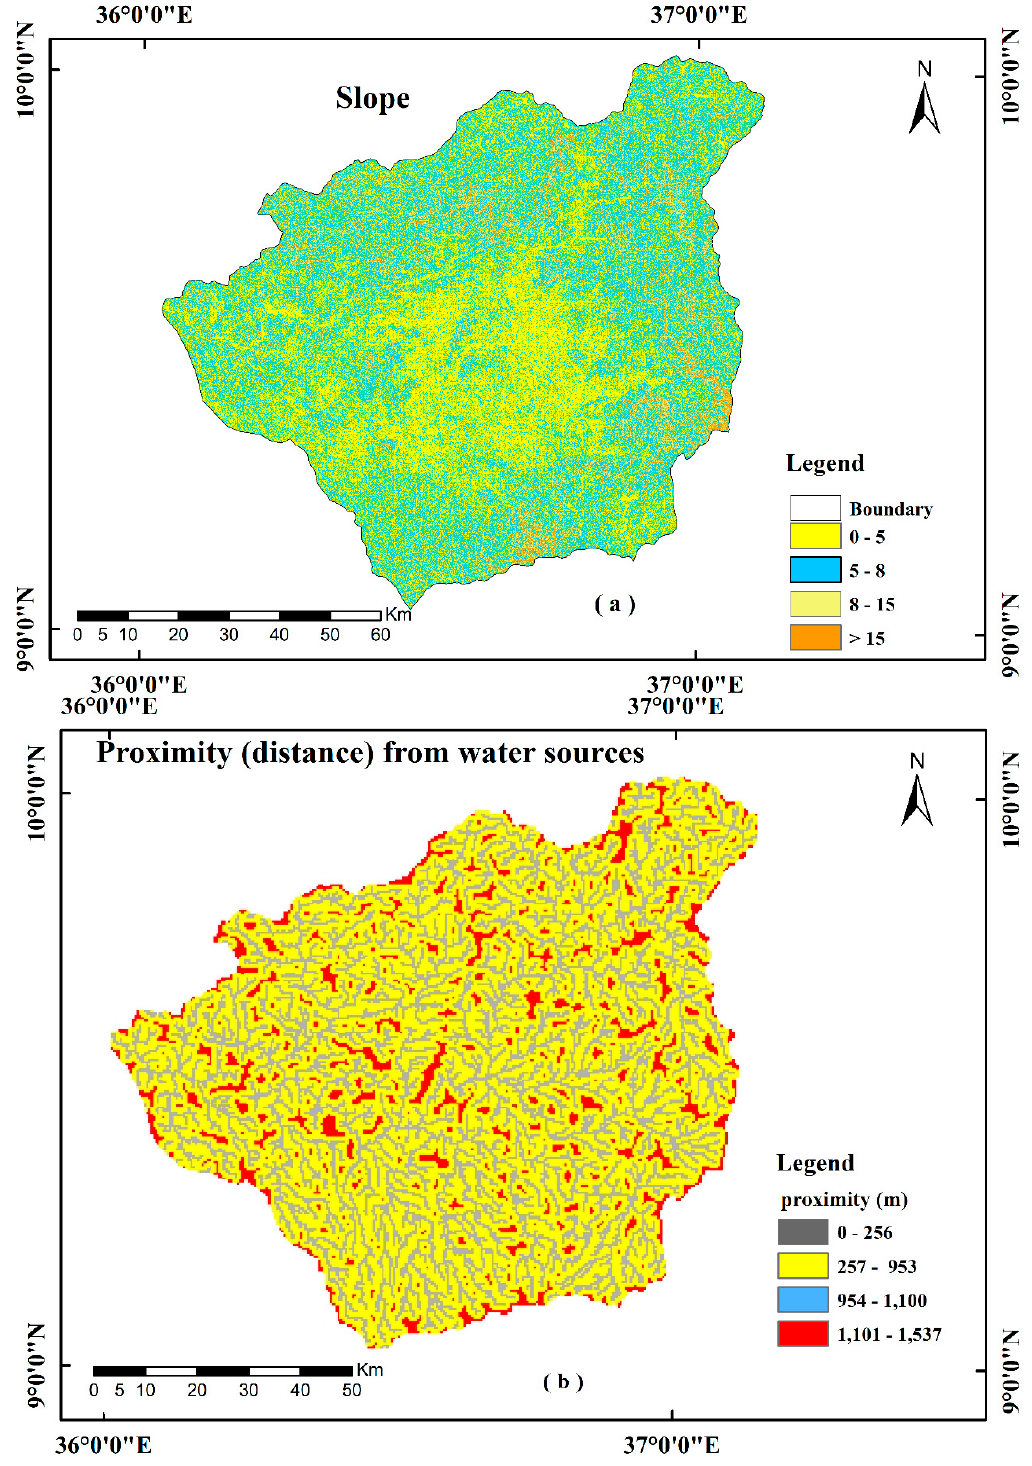
Figure 3. Slope ( a ) and proximity to a water source ( b ).